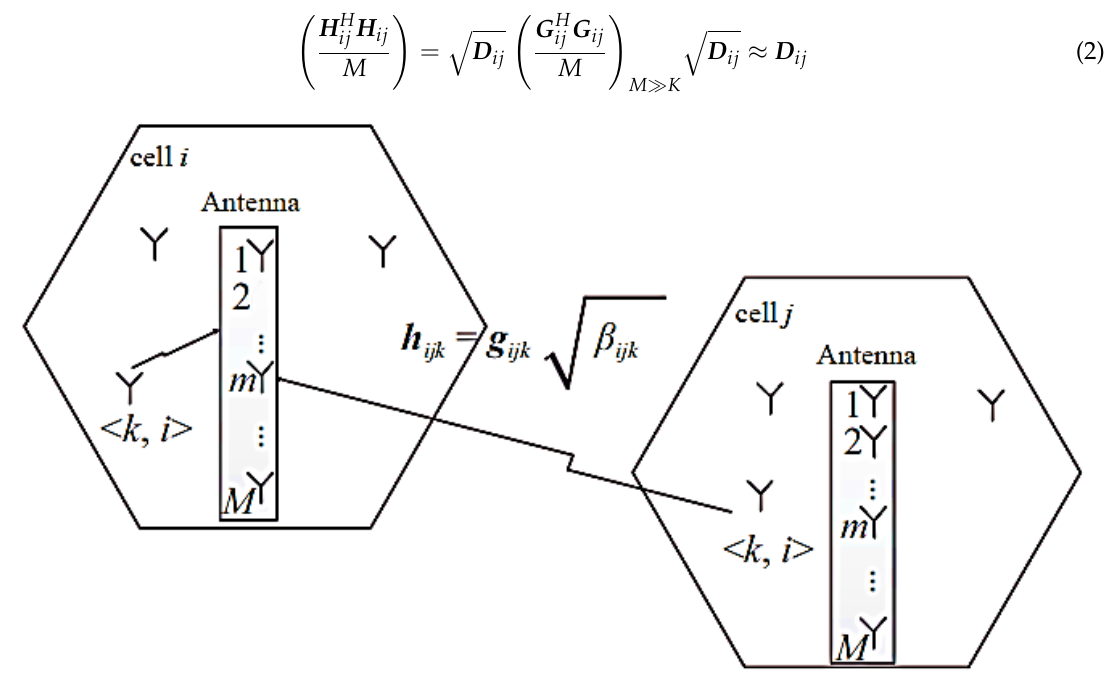
Figure 1. Massive MIMO multi-cell multi-user TDD system model.